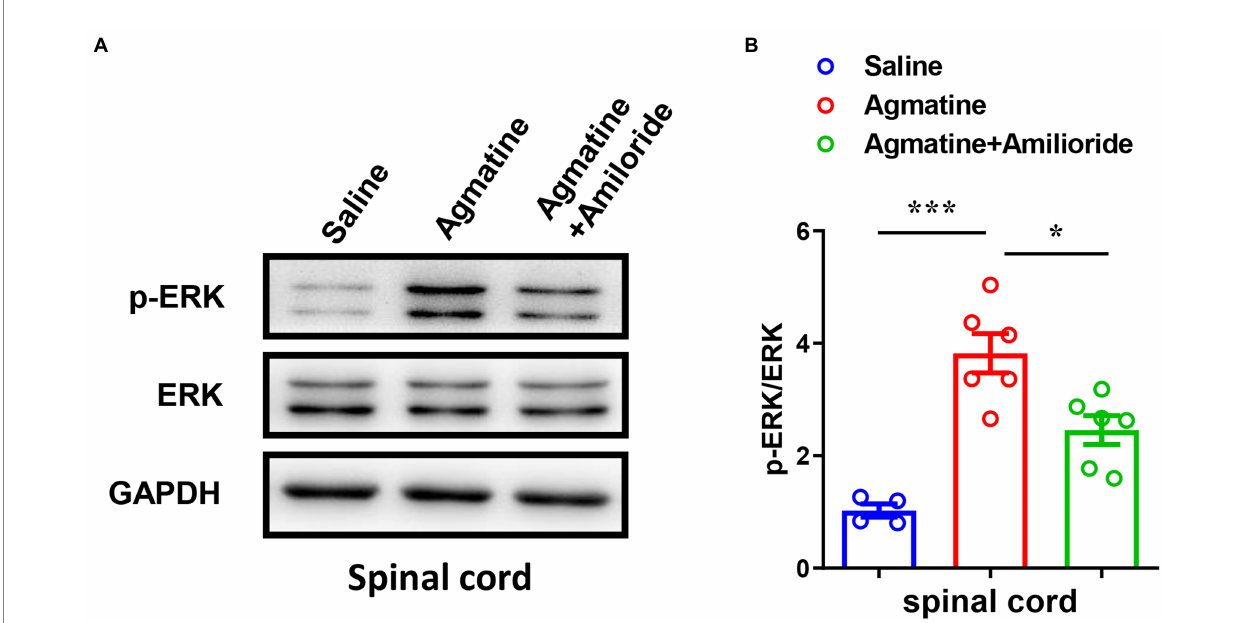
FIGURE 4 Activation of p-ERK in the spinal cord played a role in agmatine-induced itch in mice. (A,B) Western blotting (A) and quantification (B) revealed changes in the expression of p-ERK in the spinal cord 5 min after the i.d. injection of agmatine (* p < 0.05, *** p < 0.001 vs. Saline, unpaired Student’s t test; n = 4–6 per group) and an i.d. mixed injection of agmatine and amiloride (* p < 0.05 vs. agmatine, unpaired Student’s t test; n = 6 per group). All data are expressed by mean ±